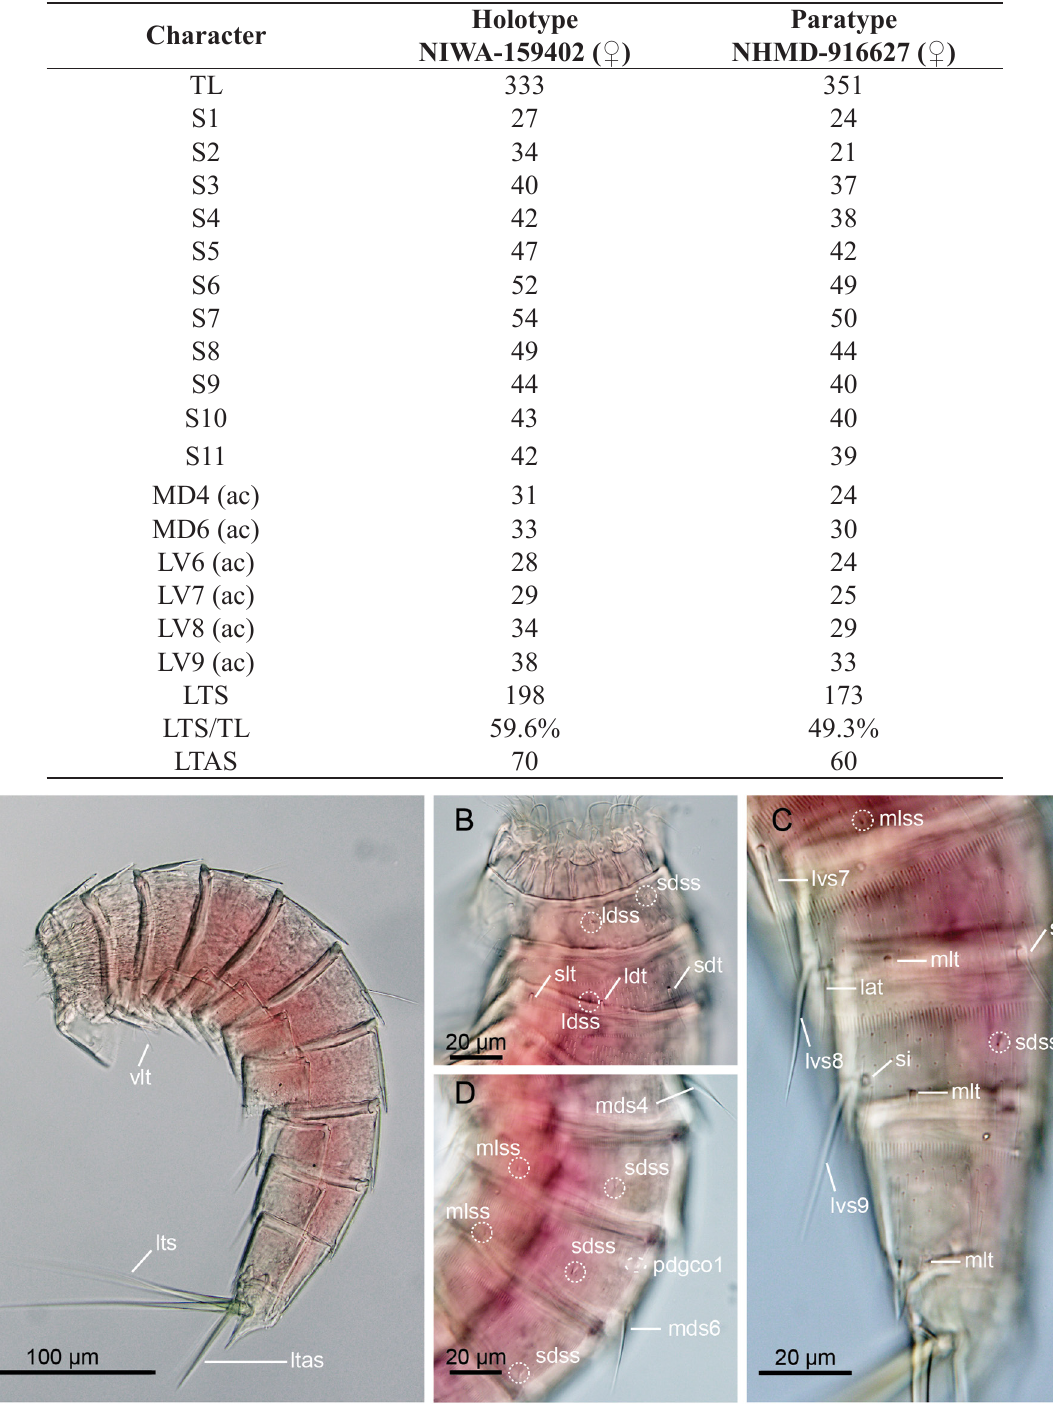
Fig. 6. Light micrographs showing overview and details of Echinoderes landersi sp. nov. A . ♀, paratype (NHMD-916627). B–D . ♀, holotype (NIWA-159402). A . Lateral overview. B . Segments 1 to 3, lateral view. C . Segments 7 to 11, lateral view. D . Segments 4 to 7, lateral view. Abbreviations: see Material and methods.